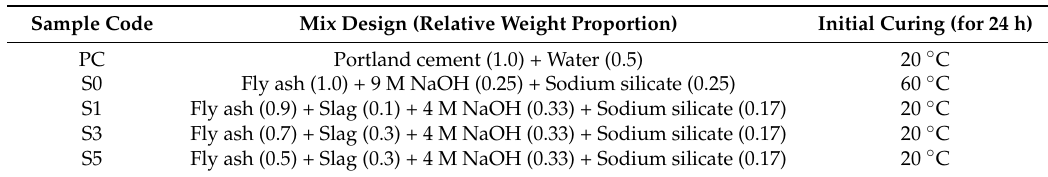
Table 2. Mix design of the